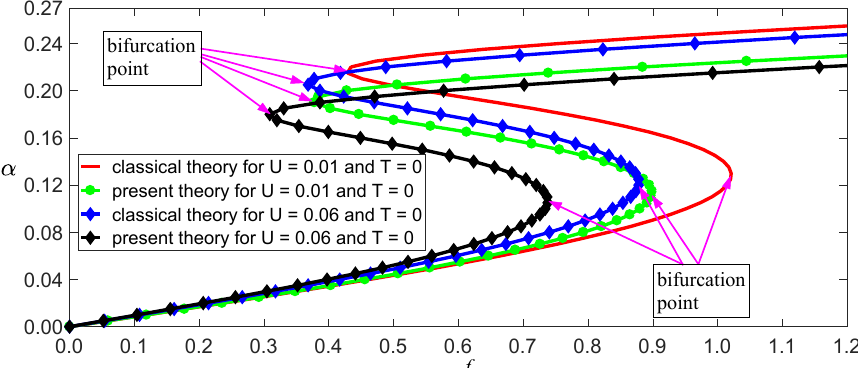
Figure 8. Load–response curves of vibration amplitudes with two electric fields for ( c , σ , T ) = ( 1, 6, 0 ) (